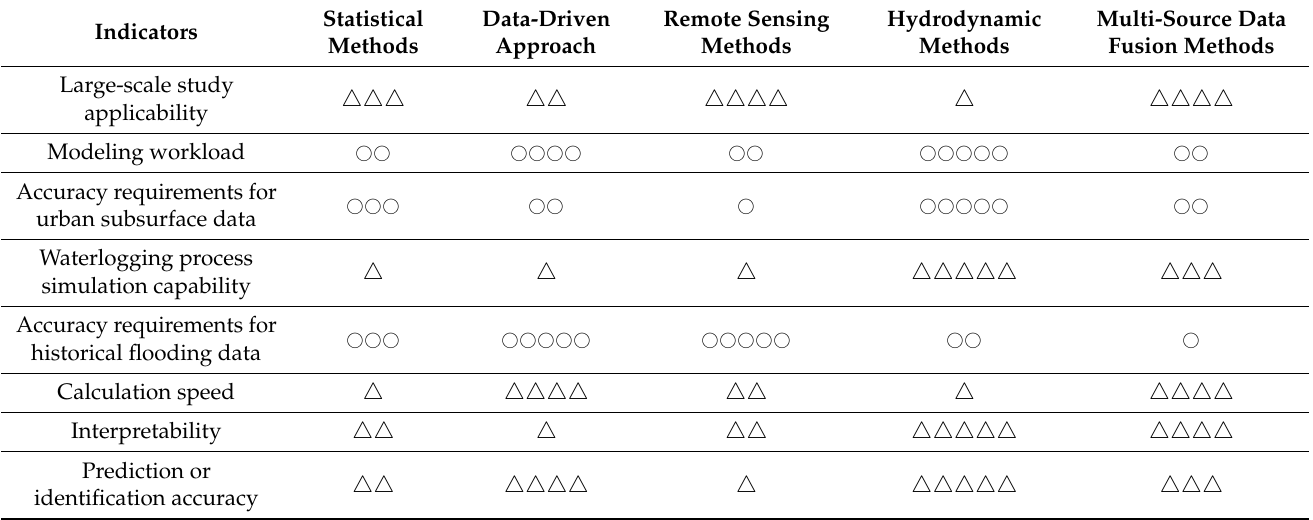
Table 1. Comparison of the main methods of current waterlogging risk